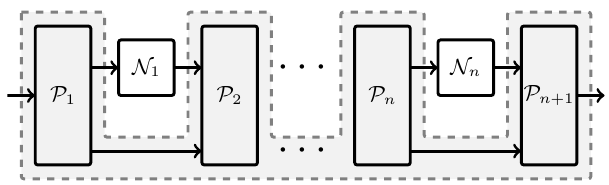
FIG. 3. Quantum comb. Given input channels N 1 , . . . , N n , the general map that outputs a channel can be represented by a quan- tum comb (gray area) realized by channels P 1 , . . . , P n + 1 , and the input channels are used by inserting them into the